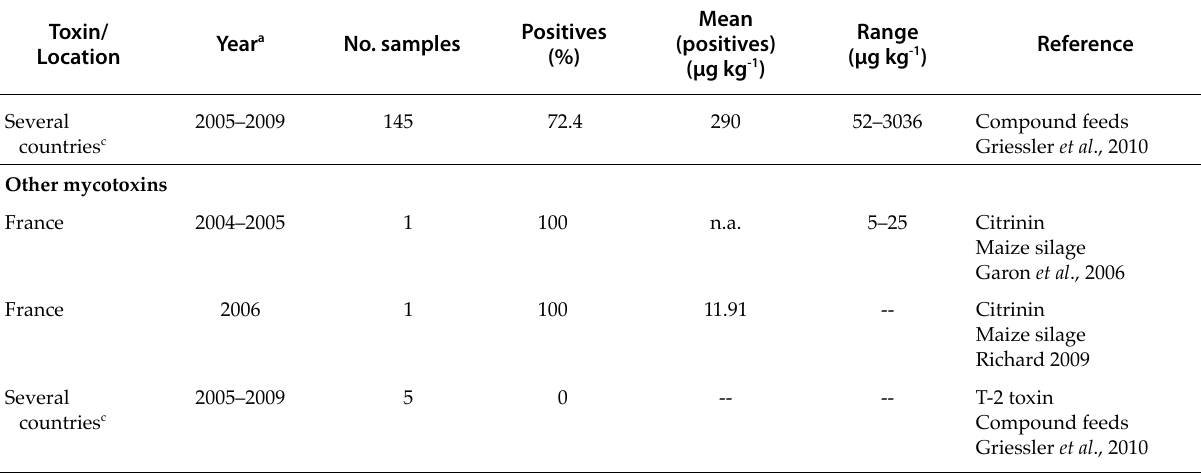
Table 8. Continues